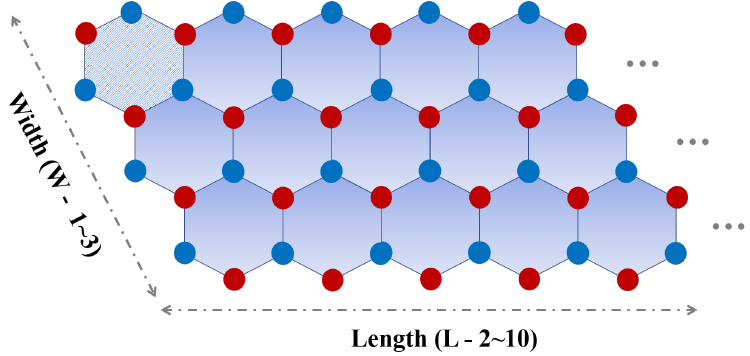
Figure 1. General schematic of the zigzag finite-length nanoribbons with different widths (W) and lengths (L). The nanoribbons with equal W and L may be regarded as parallelogrammic nanodiscs. The blue and red circles correspond to atoms in different sublattices, and to boron (B) and nitrogen (N) atoms for h-BN, respectively. A single hexagon is the basic element for the construction of zigzag nanoribbons.